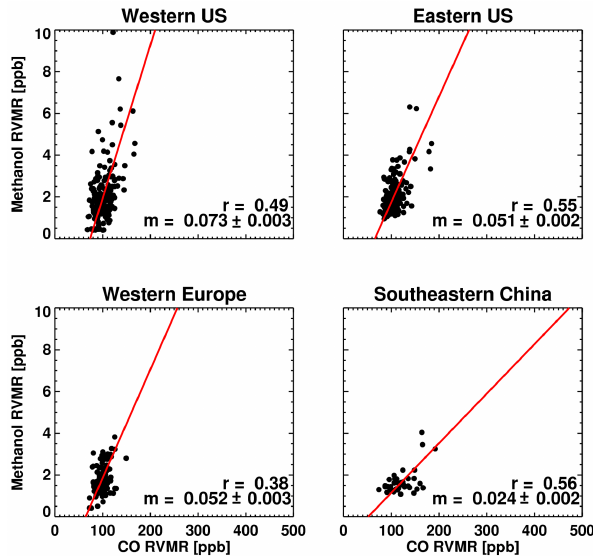
Fig. 10. Extratropical methanol:CO correlations as measured by TES during June–August. Regions are as outlined in Fig. S4. The TES CO RVMR is calculated by applying the TES methanol RVMR weighting function to the retrieved CO profile. Slopes are calculated using reduced major axis regression.